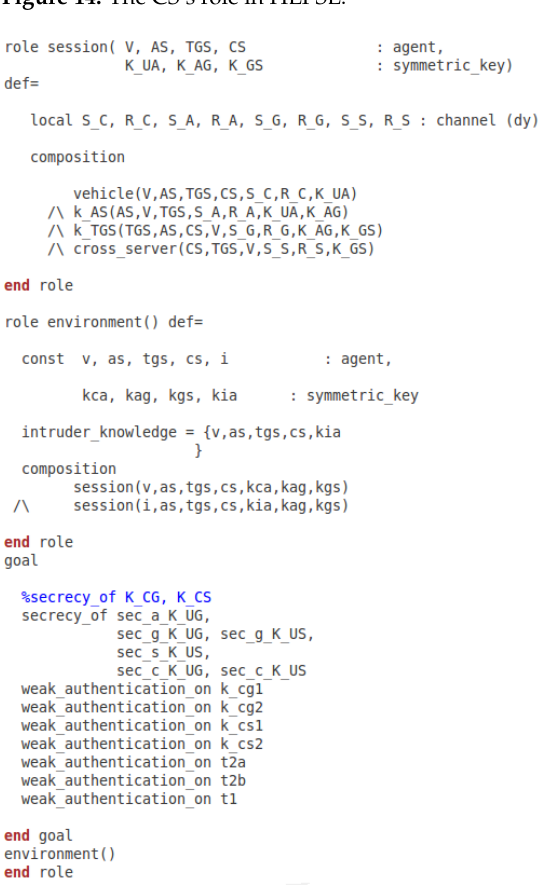
Figure 15. The session, goal, and environment in